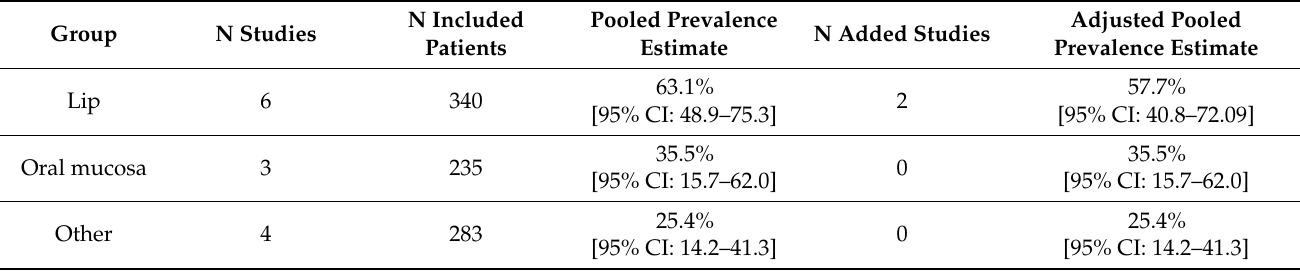
Table 5. Overview of the pooled effect estimates of